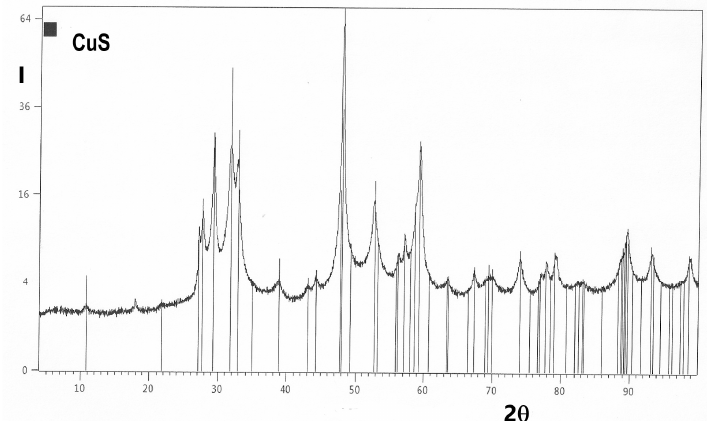
Figure 2. Nature of the reaction: X-ray diffractogram of solid obtained during thiosulfate transformation: identified as CuS.